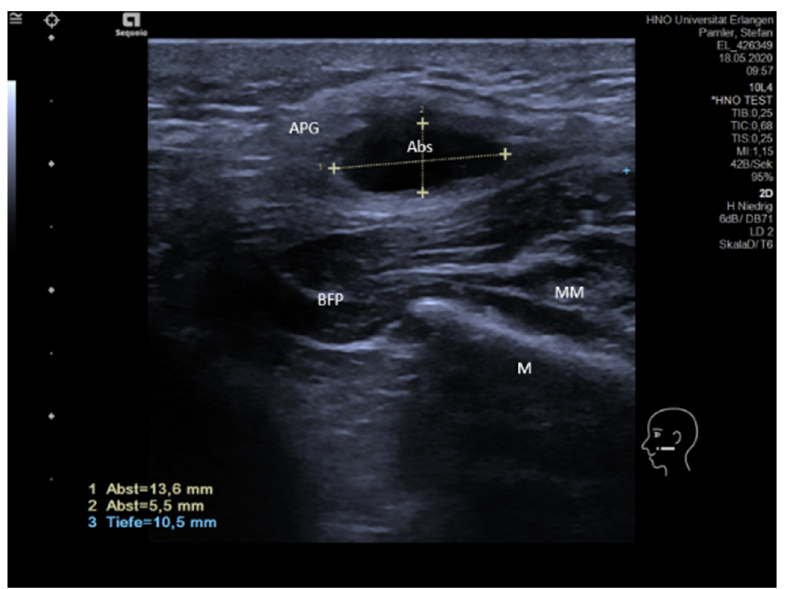
Figure 1. Abscess in the accessory parotid gland. A hypoechoic space-occupying lesion is visible within the gland measuring 13.6 × 5.5 mm (dotted lines). Abbreviations: APG, accessory parotid gland; M, mandible; MM, masseter muscle; BFP, buccal fat pad; ABSC, abscess. Chronic sialadenitis is characterized by a tendency towards a smaller gland size